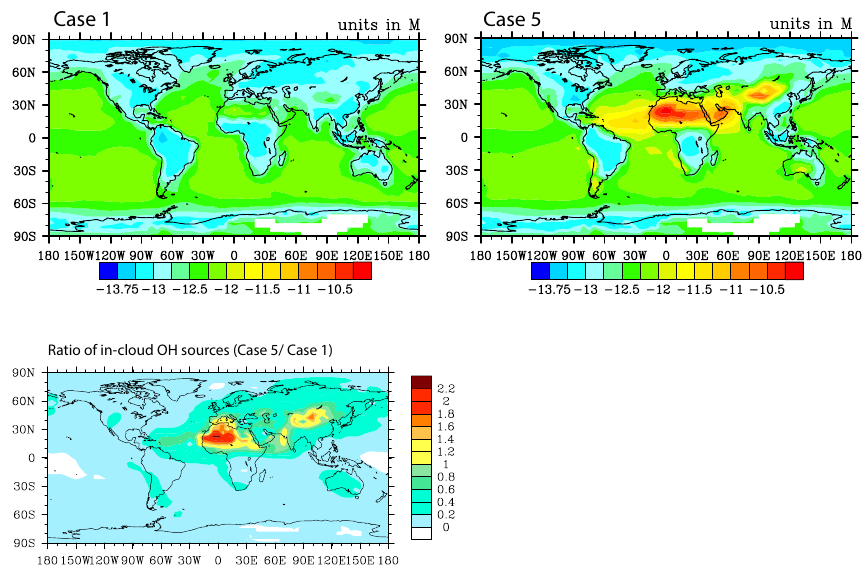
Figure 5. The predicted aqueous OH concentration (units in mol/L) in cloud water near 971hPa in Case 1 (without Fe chemistry) and Case 5 (with Fe chemistry). The ratio of annual mean cloud water OH radical production rates in Case 5 to that in Case 1 is also shown (2nd row). The value shown is the logarithm of the ratio.